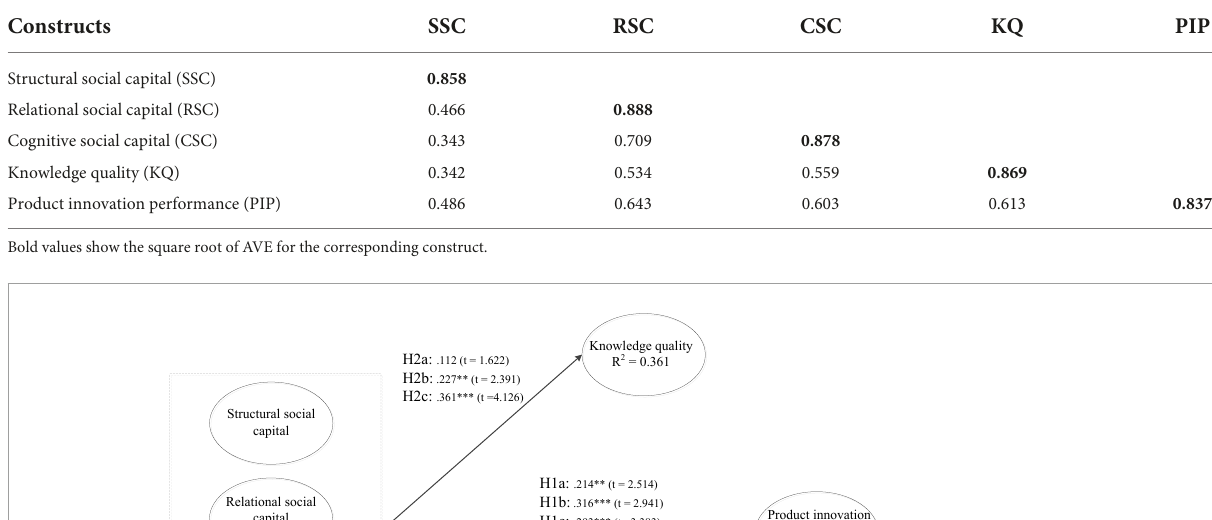
TABLE 3 The indices for discriminant validation.